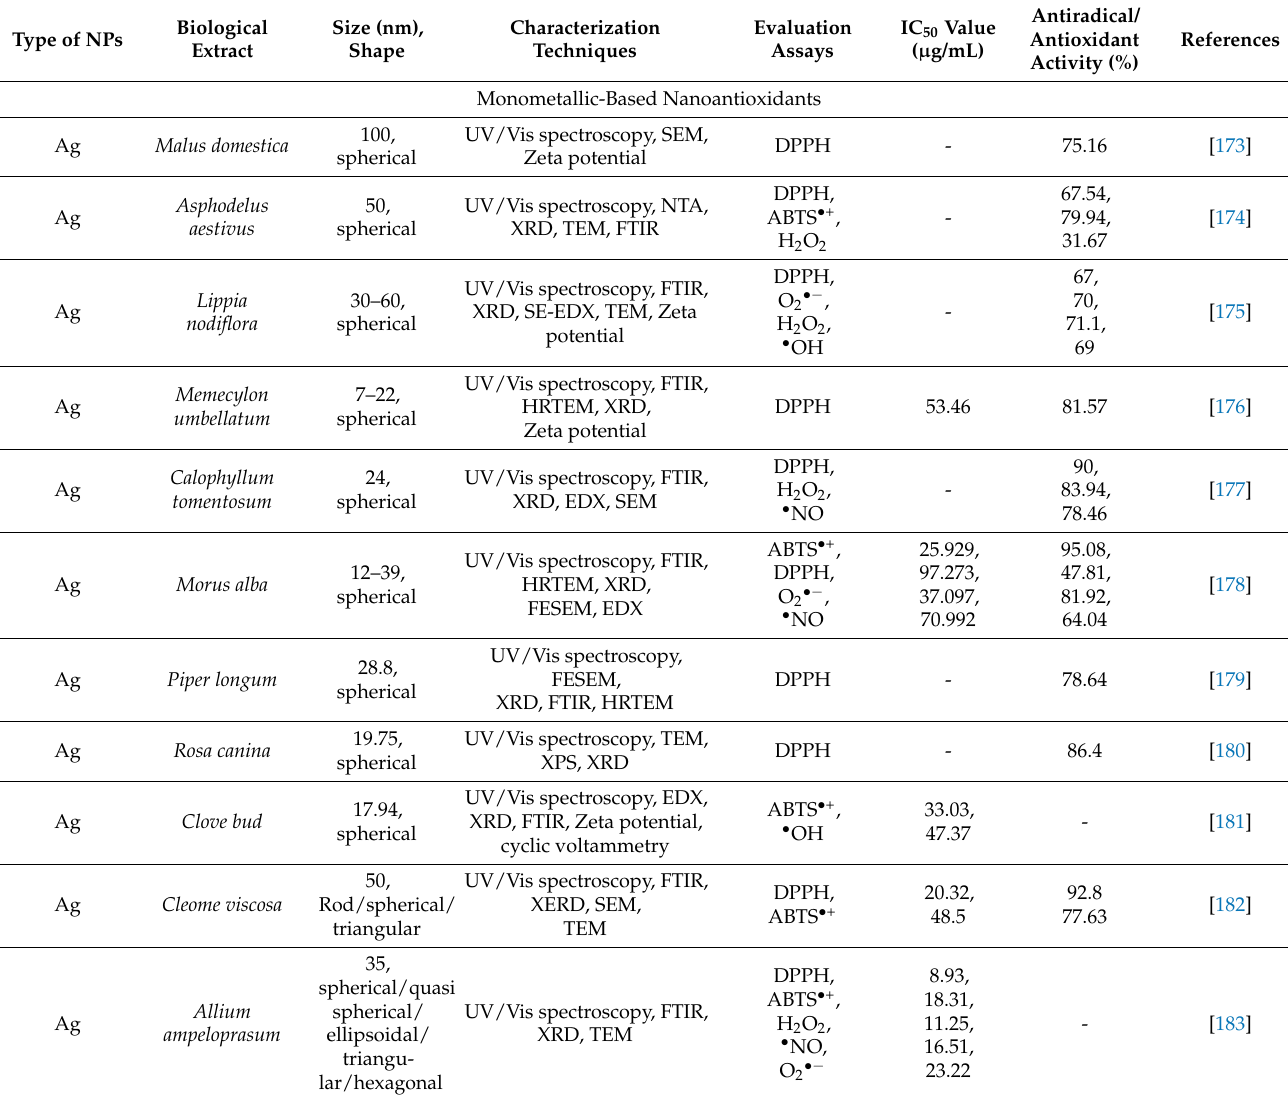
Table 2. List of biologically fabricated monometallic, bimetallic, and metal oxide NPs endowing antioxidant potential. Biological Type of NPs